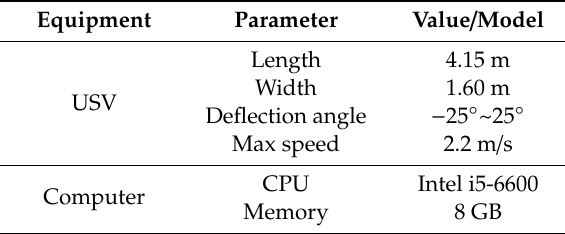
Table 1. Experimental equipment.